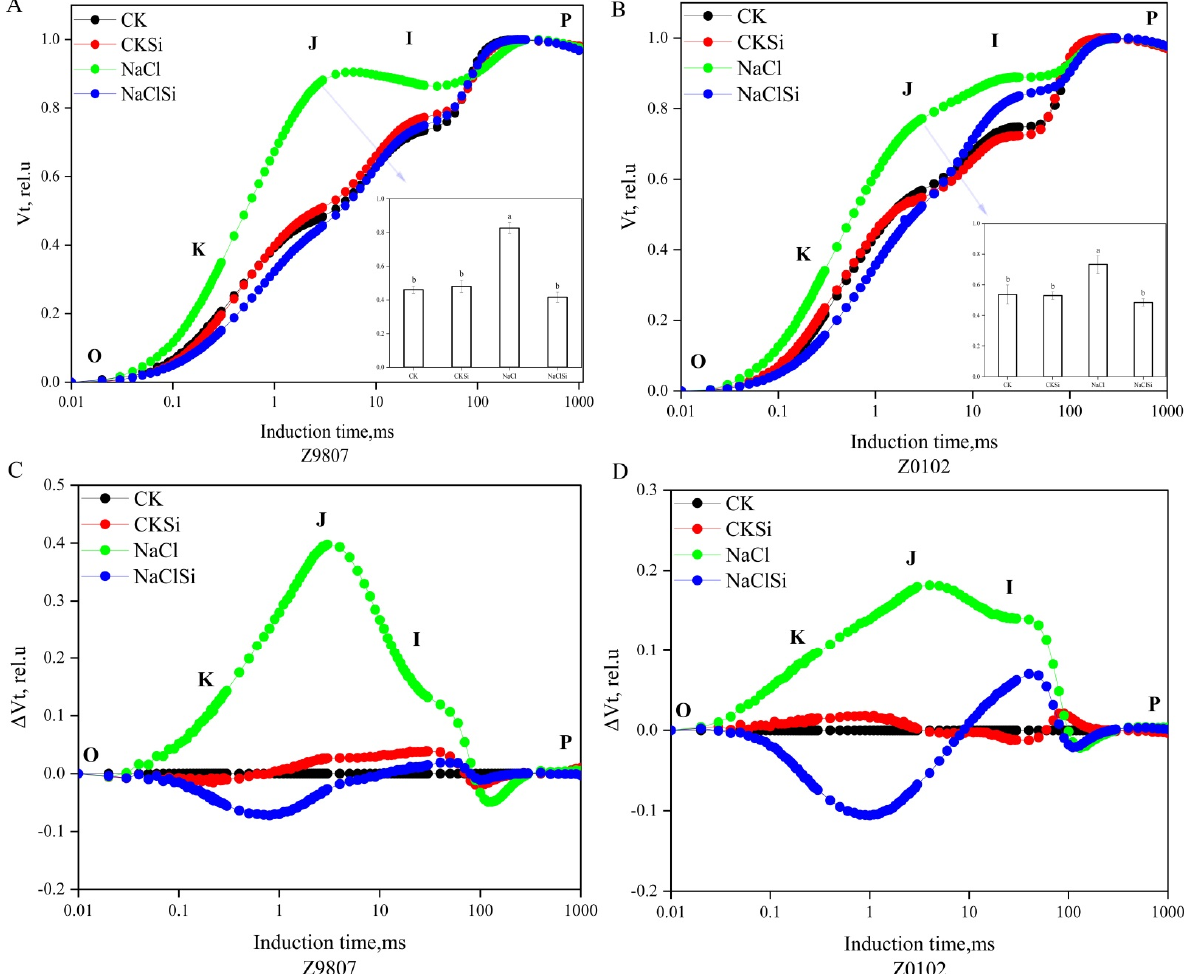
Figure 8. Effects of exogenous Si on relative chlorophyll a fluorescence [( A ) (Z9807), ( B ) (Z0102), V t = (Ft − F0)/(Fm − F0)], and the relative differences of chlorophyll a fluorescence [( C ) (Z9807), ( D ) (Z0102), Δ V t = V t (different treatments without CK) − V t (CK)] in third fully expanded leaves. Each